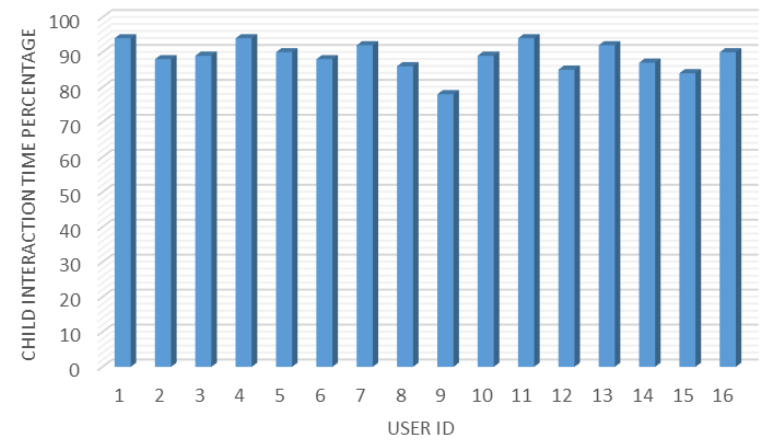
Figure 8. Percentage of child interaction time with the robot system.